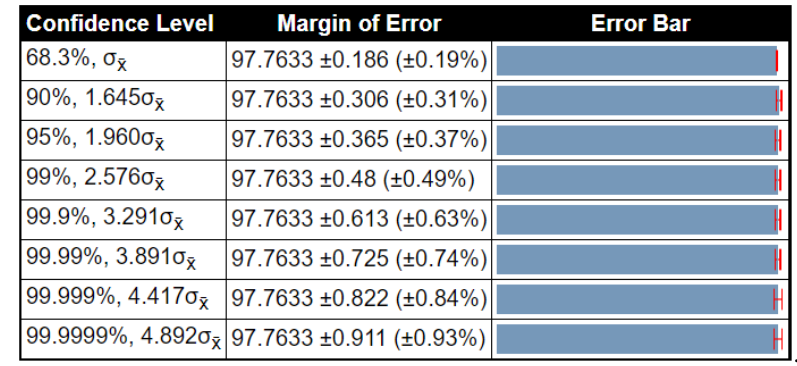
Figure 8. Confidence interval of statistical test for different critical values of t -test (BraTS 2015 dataset).